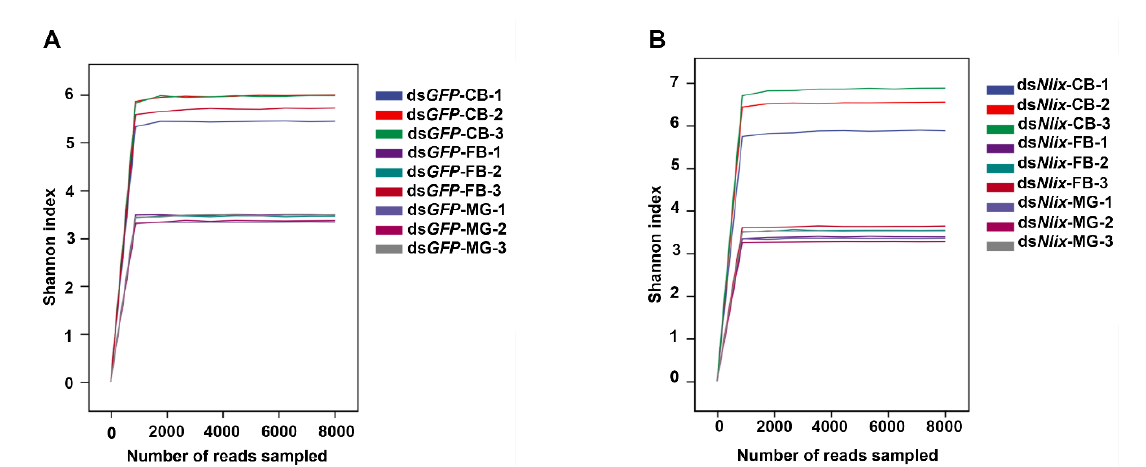
Figure A1. Shannon rarefaction curve of ( A ) the dsGFP-treated samples and ( B ) the ds Nlix -treated samples. CB: copulatory bursa; FB: fat body; MG: midgut.